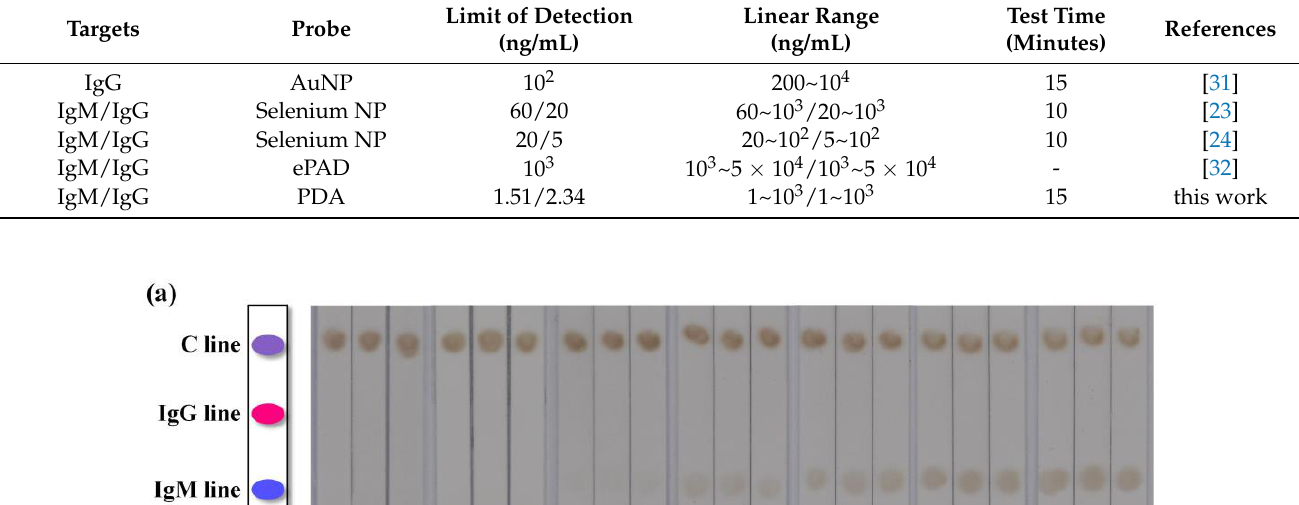
Table 1. Results comparison of colorimetric LFIAs for IgG and IgM detection.